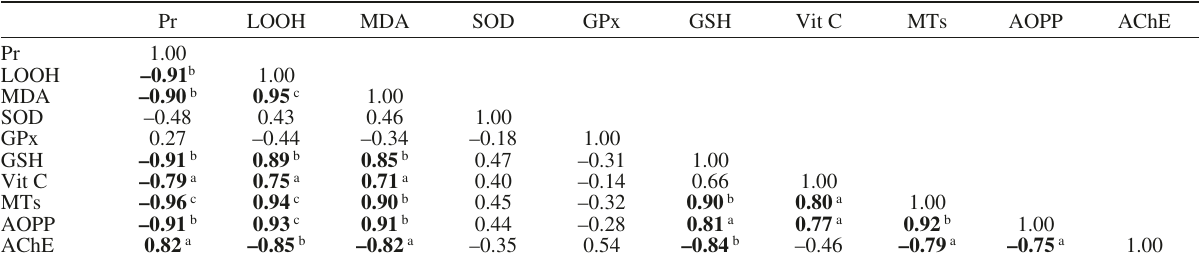
Table 2. – Correlation (Pearson) between various antioxidant parameters in gills from control and exposed M. stultorum. Significance level at p<0.05=a, p<0.01=b, p<0.001=c.